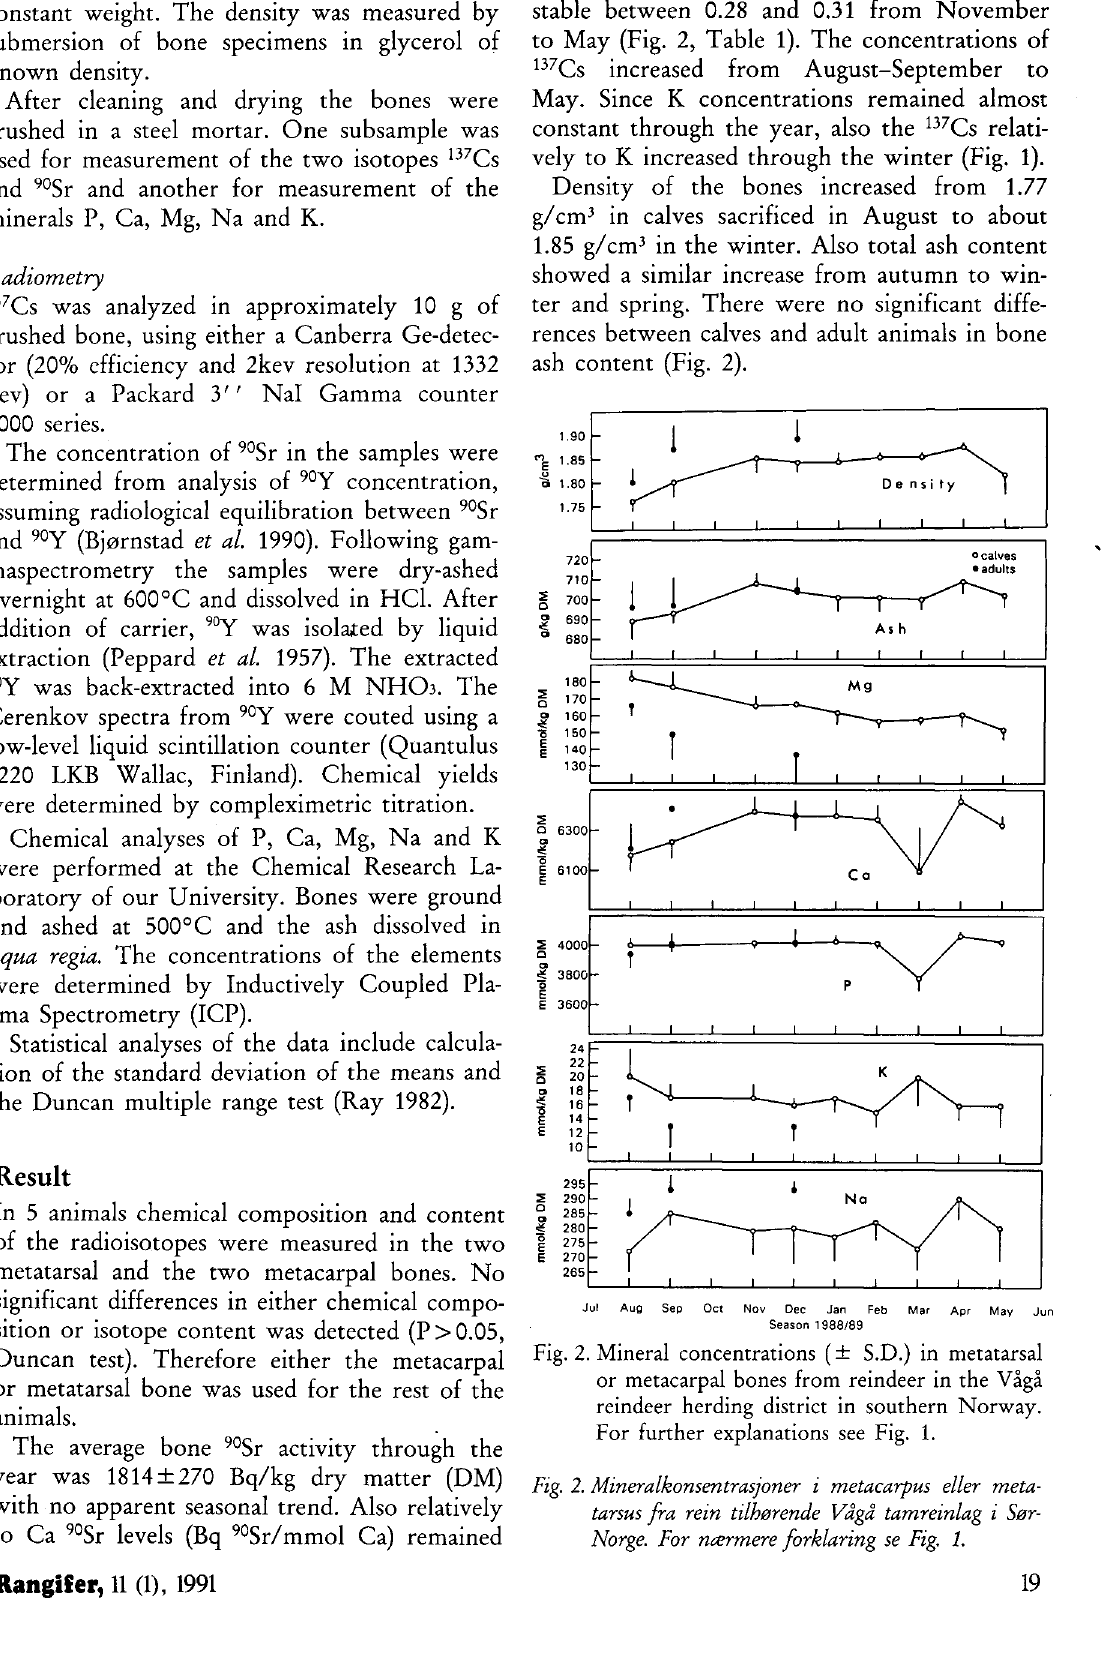
Fig. 2. Mineral concentrations ( ± S.D.) in metatarsal or metacarpal bones from reindeer in the Vågå reindeer herding district in southern Norway. For further explanations see Fig. 1. Fig. 2. Mineralkonsentrasjoner i metacarpus eller meta tarsus fra rein tilhørende Vågå tamreinlag i Sør- Norge. For nærmere forklaring se Fig.